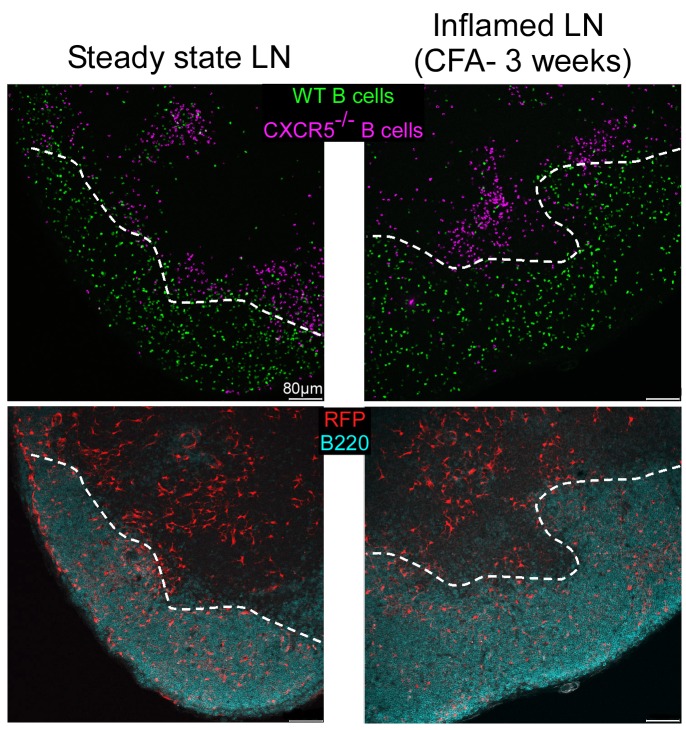
CXCR5-deficient B cells fail to access inflamed B cell follicles.CD21cre-RFP chimeras were untreated (left panel) or injected (right panel) with an emulsion of CFA/PBS in the ears. Three weeks later, recipients were injected with a cohort of CMFDA-labeled Wt-deficient B cells (green) and Celltrace violet–labeled CXCR5-deficient B cells (violet). One day later, ear draining LNs were sectioned, stained for B220 (blue) expression, and imaged by confocal microscopy. RFP+ cells appear in red. Data are representative of two different experiments (three mice per experiment).